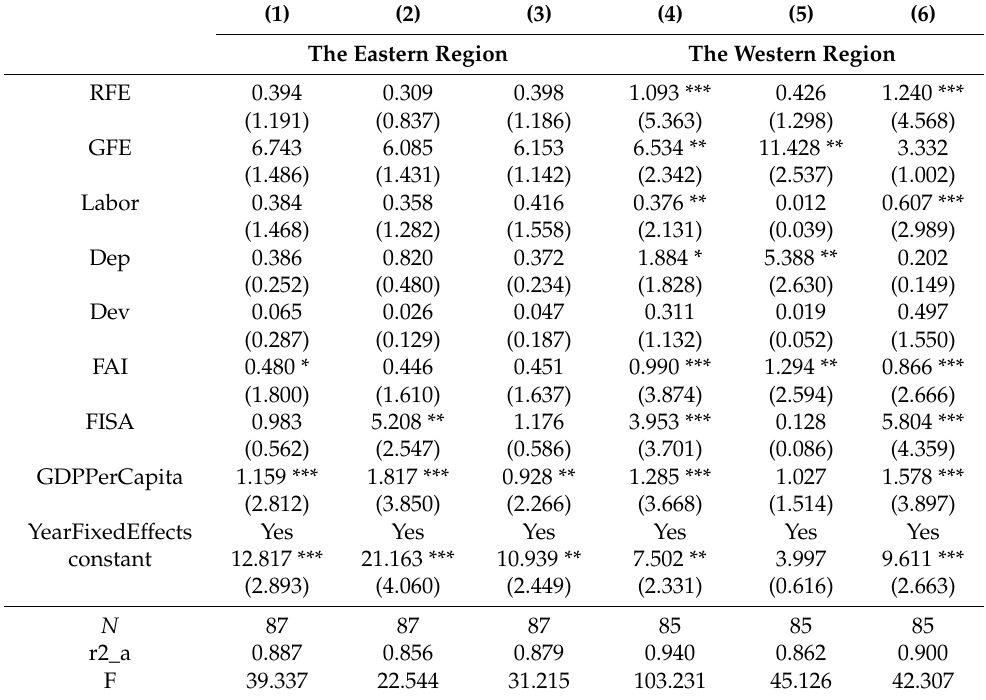
Table 7. Financial Efficiency, Regional Distribution, and Agricultural Scientific and Technological Innovation.